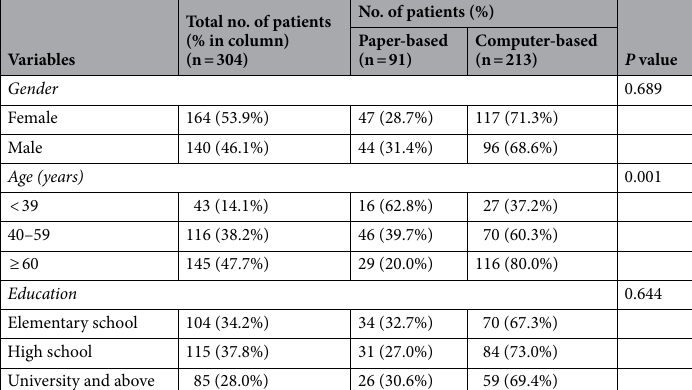
Total no. of patients (% in